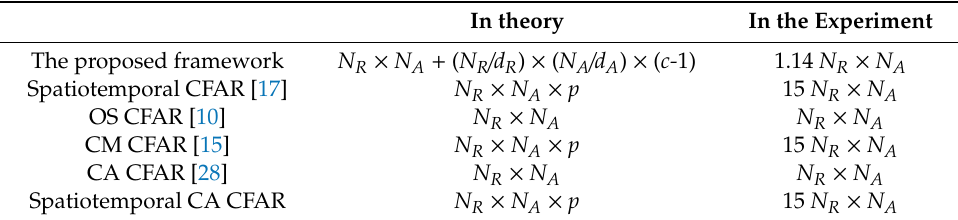
Table 3. The memory